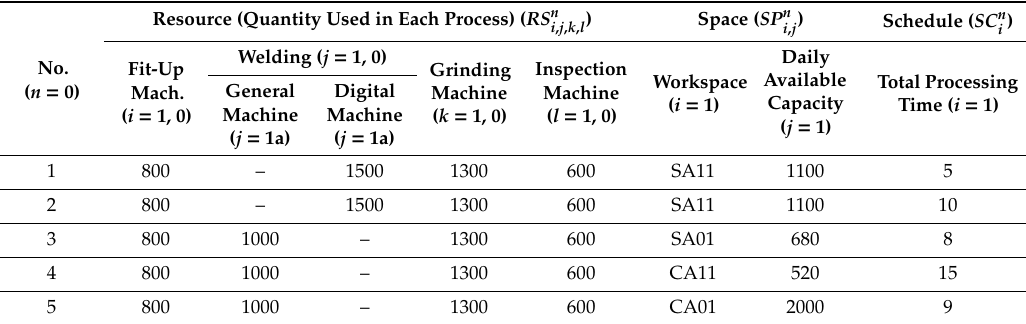
Table 6. An example of the TT1 block-based resource, space, and schedule among the PPR-SS through the process-based Petri-net